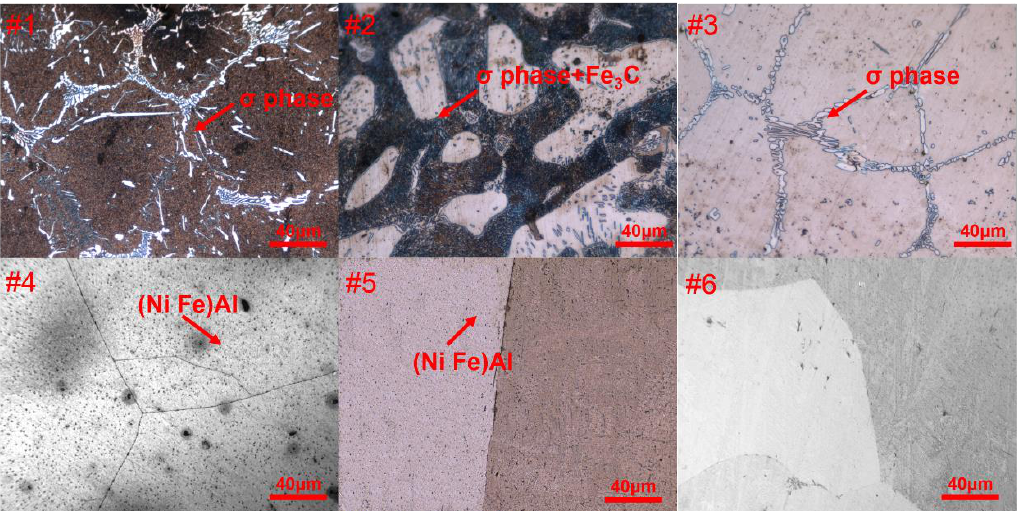
Figure 1. Metallography structure of alloys. FeCr phase appeared in #1, 2, and 3 alloys, (Ni Fe)Al appeared in #4 and #5 alloys. FeCr and (Ni Fe)Al’s components are presented in Table 2. There wa s no obvious grain boundary defect in the matrix in #1, #2 and #3 alloys’ grain, whil st the second phase had an obvious grain boundary. The grain size of the matrix could reach tens of microns, whilst the grain size of the second phase was only a few microns. The second-phase grains were dendritic, a small portion of which were scattered in the matrix grains. The grain sizes of #4, #5 and #6 alloys reached hundreds of microns, and the alloys ’ grain boundaries were clean, without the second phase at the grain boundaries.